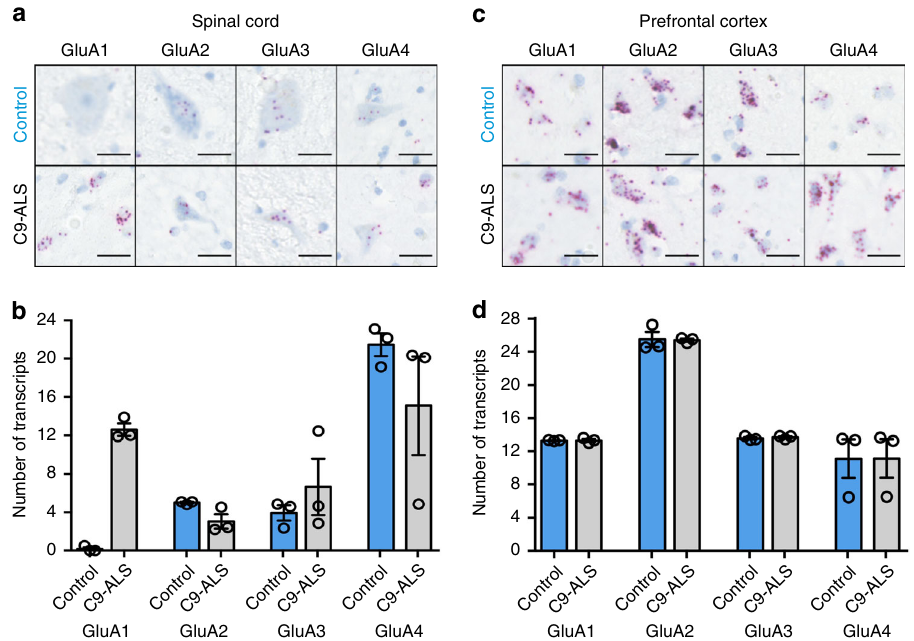
Fig. 7 AMPAR subunit expression in post-mortem spinal cord of healthy patients and ALS patients with C9ORF72 repeat expansion. a Representative RNAscope® images showing the expression of AMPAR GluA1 — four transcripts in the anterior horn of cervical spinal cord sections from an ALS patient ( C9ORF72 ) and an age-matched healthy patient and reveals increased expression of GluA1 in ALS patient sample. Scale bar, 25 µ m. b Quanti fi cation of the mean ± s.e.m. expression levels of AMPAR transcripts in spinal cord samples from three independent patients and controls. Note the lack of GluA1 transcript expression in control spinal cord samples and strong expression in patient samples. c Representative RNAscope images showing the expression of AMPAR GluA1 — four transcripts in the prefrontal cortex from an ALS patient ( C9ORF72 ) and an age-matched healthy patient. Scale bar, 25 µ m. d Quanti fi cation of the mean ± s.e.m. expression levels of AMPAR transcripts in prefrontal cortex samples from three independent patients and controls showing equivalent expression of all guide lines using the following primers G 4 C 2 Fw: 5 ′ -CAAGGAGGGAAACAA CCG-3 ′ G 4 C 2 Rev: 6-FAM- 5 ′ -GGAAAGCAAGGAAGAGGC-3 ′ . PCR products were separated on an ABI 3130xl analyzer (Life Technologies) and data were analyzed using GeneMarker software (Soft Genetics). Southern blot . Southern blot analysis was used to analyze the C9ORF72 repeat expansion mutation as described 69 . DNA was isolated using Wizard ® genomic DNA puri fi cation kit (Promega). 20 µ g of DNA was digested overnight with Xba endonuclease, separated on a 0.8% agarose gel electrophoresis, gel was subsequently depurinated, denatured, and transferred overnight on to a positively charged nylon membrane (Roche). The membrane was UV cross-linked and hybridized overnight at 47 °C with a digoxigenin (DIG)-labeled PCR probe. PCR probe was synthesized from genomic DNA using PCR DIG probe synthesis kit (Roche) using following washed and labeled with anti-DIG antibody and developed using CDP-Star reagent as per manufacturer ’ s recommendation (Roche). MN differentiation . MN differentiation from iPSCs was performed using estab- lished protocol 24 with minor modi fi cations. iPSCs were dissociated into single cells using 1 ×Accutase, 2 ×10 6 iPSCs were neuralized as a suspension culture using SB- 431542 (20 µ M), LDN-193189 (0.1 µ M), and CHIR-99021 (3 µ M) in N2/B27 media